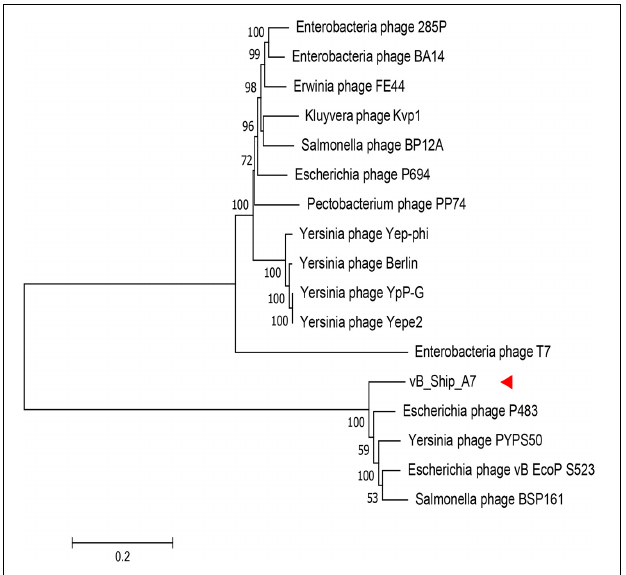
FIGURE 4 | Phylogenetic tree based on the whole genome sequence of vB_ShiP-A7 and its related phages. After comparing the genome sequences of these phages using the ClustalW program, a phylogenetic tree was generated using the neighbour-joining method with 1000 bootstrap replicates.vB_ShiP-A7 was marked by a red arrow.